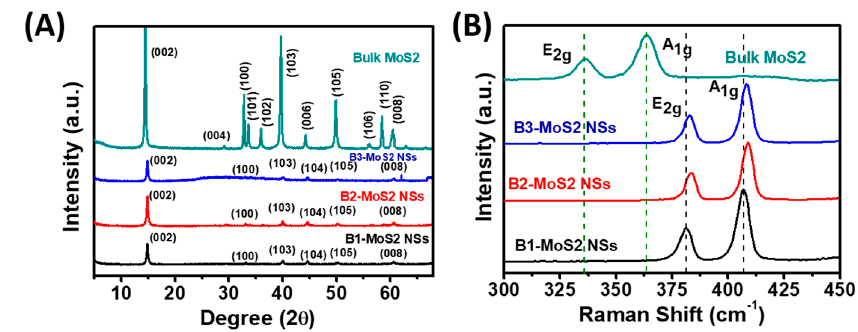
Figure 5. ( A ) XRD analysis and ( B ) Raman spectra of synthesized MoS 2 NSs and bulk MoS 2 .